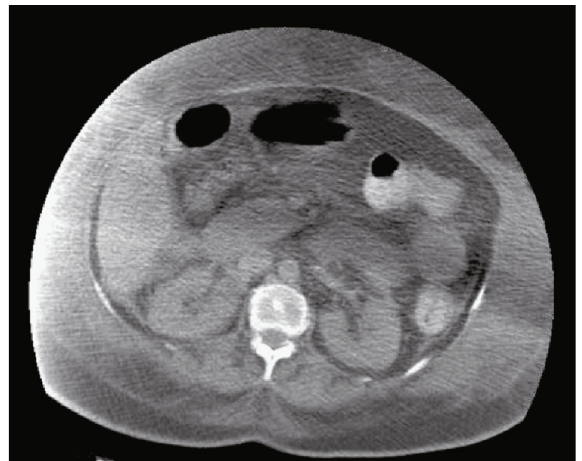
Figure 3: Abdominal tomography evidencing marked increase of the abdominal wall soft tissues ’